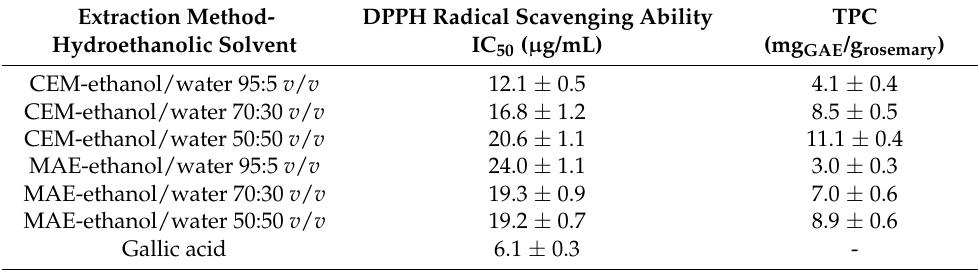
Table 2. The effect of the extraction method and solvent on the antioxidant activity and the total phenolic content recovered from dried rosemary